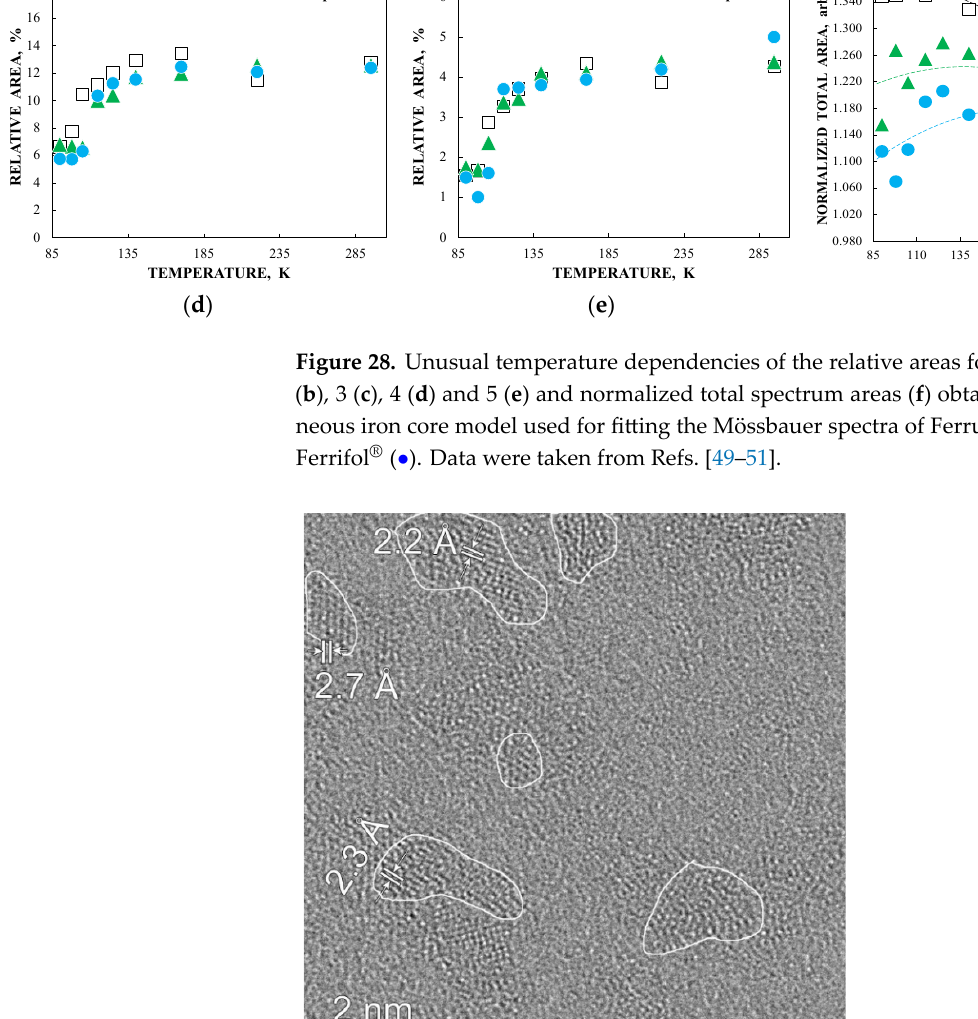
Figure 29. High ‐ resolution transmission electron microscopy image of Ferrifol ® . The iron cores in this image constitute ordered domains with lattice periodicities between 2.2 and 2.7 Å. Adapted